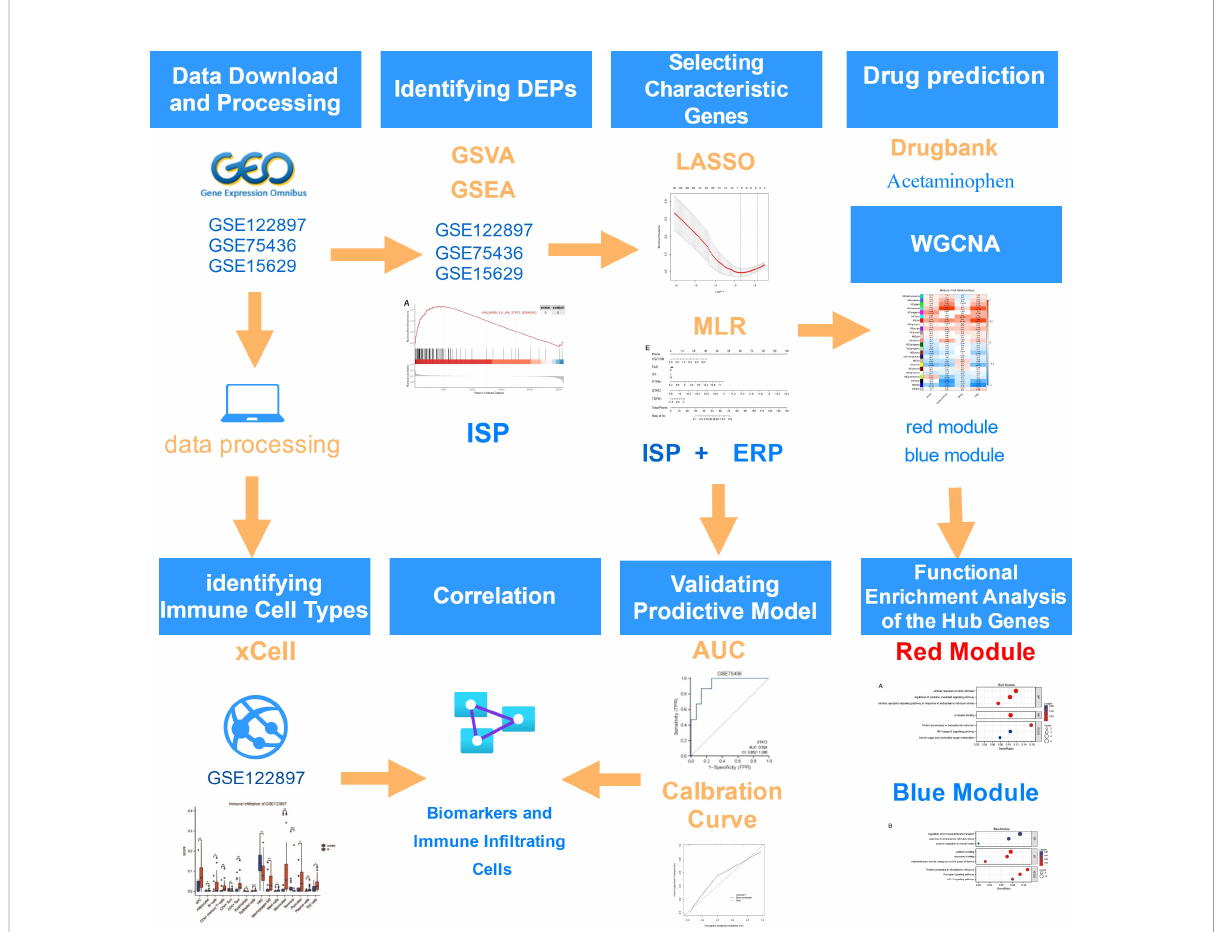
FIGURE 1 Flowchart on the construction and validation of the pathogenesis-related key biomarkers and pathways of intracranial aneurysm (IA) onset. GSVA, Gene Set Variation Analysis; GSEA, Gene Set Enrichment Analysis; ISP, IL6/JAK/STAT Signaling Pathway; ERP, Estrogen Response Pathway; LASSO, Least Absolute Shrinkage and Selection Operator; MLR, Multivariate Logistic Regression; AUC, Area Under the Curve; WGCNA, Weighted Gene Co-expression Network Analysis. This fl owchart was generated and edited with the online free application, diagrams.net (https://app.